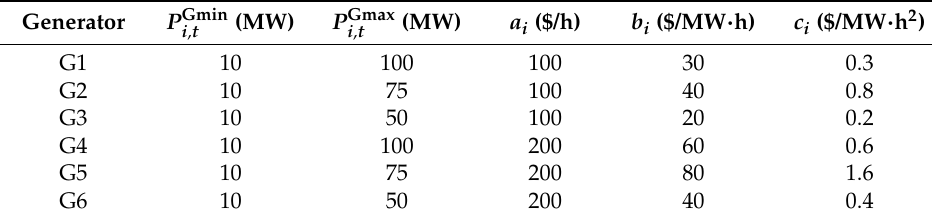
Table 1. Conventional unit